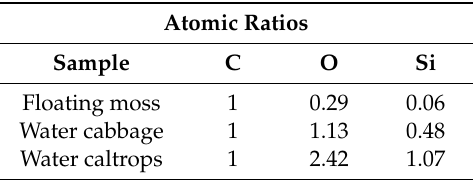
Figure 3. Field emission scanning electron microscopy (FESEM), transmission electron microscopy (TEM) and energy-dispersive X-ray spectroscopy (EDX) images (from left to right) of ( a ) Floating moss sample; ( b ) Water cabbage sample; and ( c ) Water caltrops sample. Table 1. The C, O, and Si contents of the samples obtained by energy-dispersive X-ray spectroscopy (EDX) analysis.